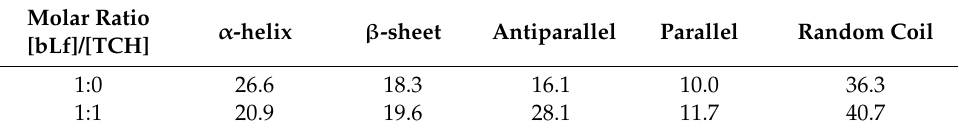
Table 5. Secondary structure fractions of bLf complexes (CD spectra) with TCH.